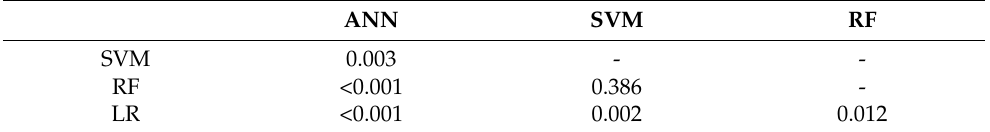
Table 4. p -values from statistical comparisons of the variance in accuracy between machine learning methods. F-tests were used with the FDR correction for p -values.